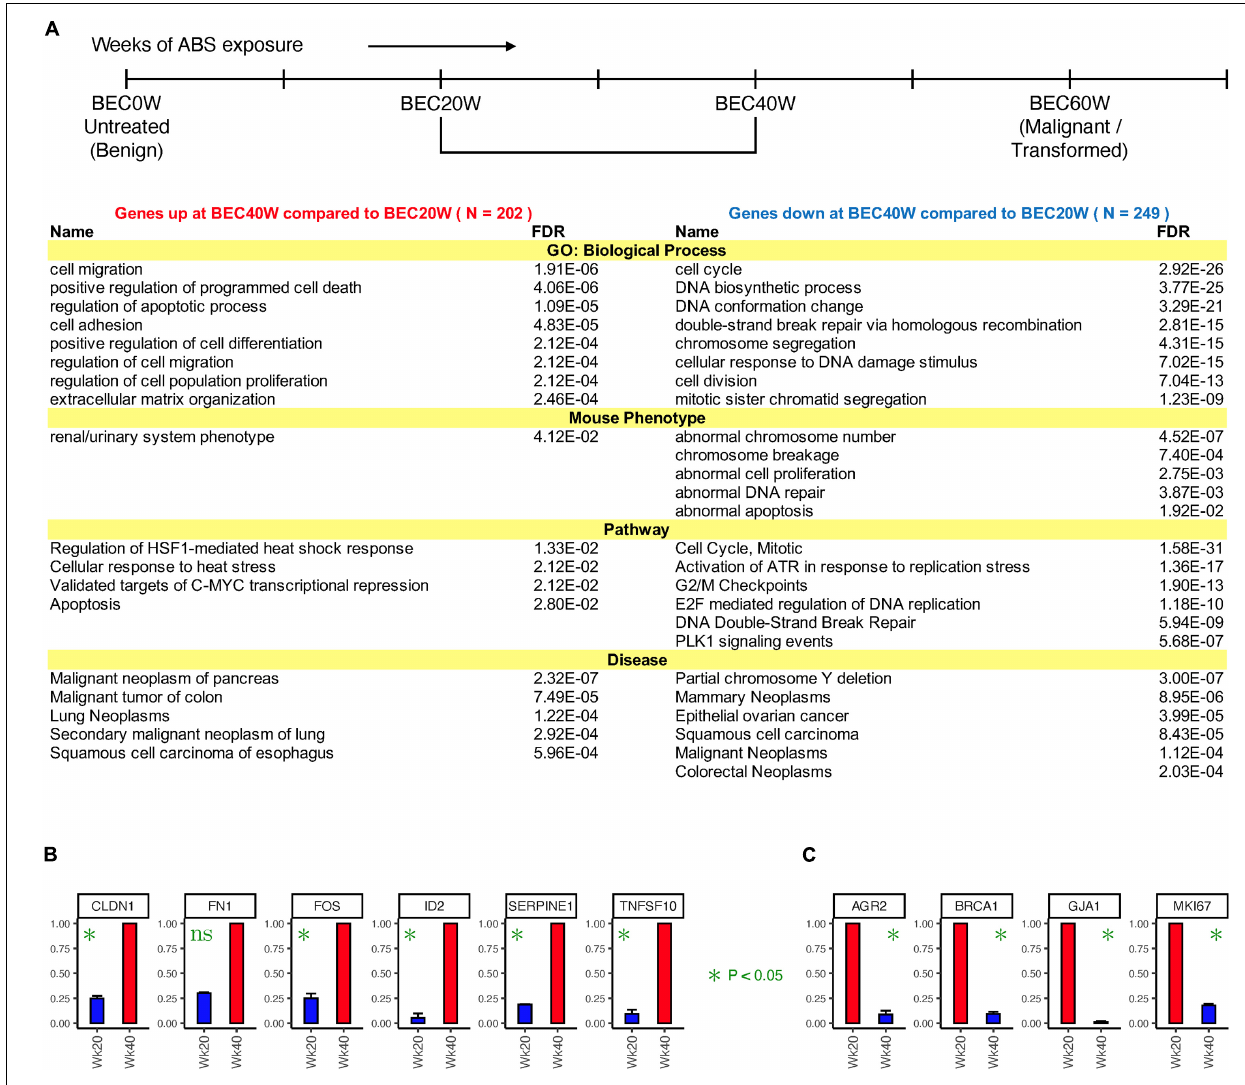
FIGURE 2 | Time series changes in gene expression from BEC20W to BEC40W. (A) Biological processes, mouse phenotypes, pathways, and diseases enriched in the genes that went up (left) or down (right) twofold or more from BEC20W to BEC40W. (B,C) Confirmatory quantitative PCR for randomly selected genes with increased transcript levels or reduced transcript levels, respectively, between BEC20W and